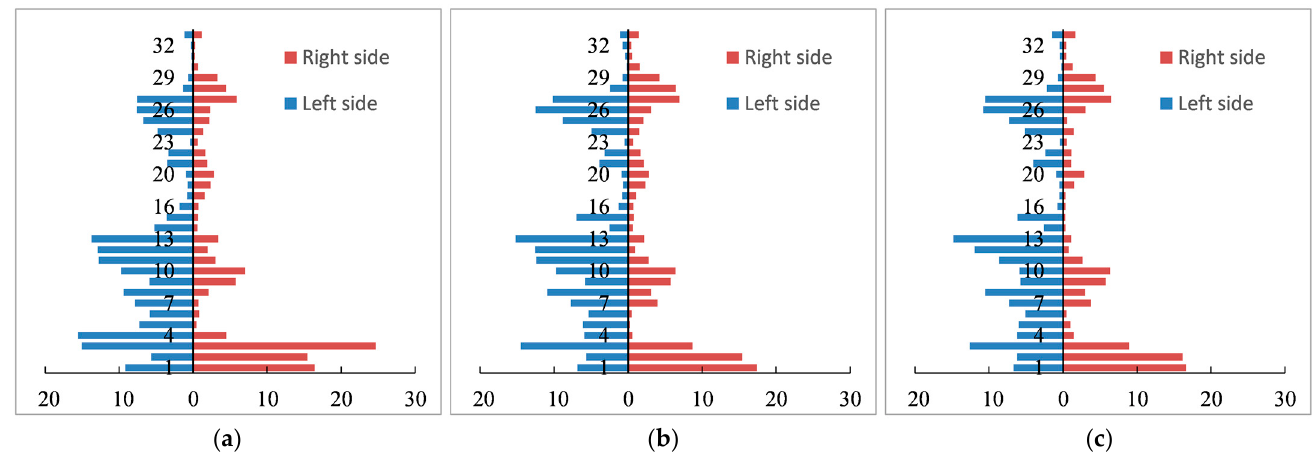
Figure 3. LF of different buffers on the left and right sides along the QTR.